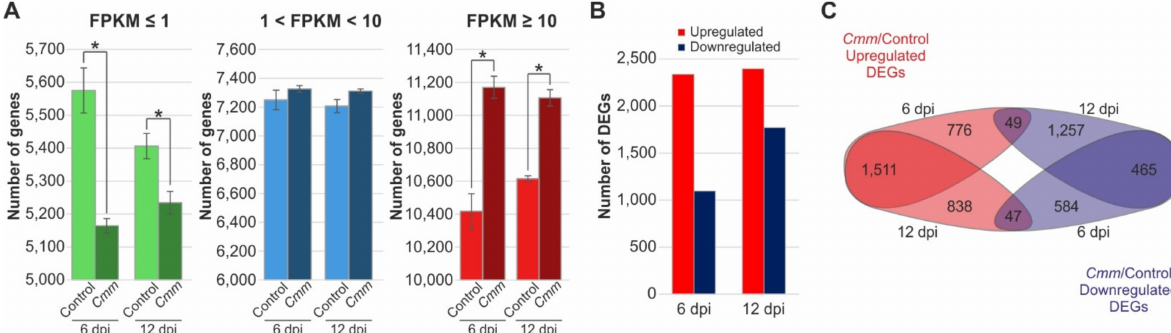
Figure 2. Overview of differentially expressed genes (DEGs) upon Cmm infection at 6 and 12 dpi. ( A ) Comparative analysis of gene expression distribution among the samples of control and Cmm infected plants. Red bars depict the highly expressed genes (FPKM ≥ 10), blue bars the genes with intermediate level of expression (1 < FPKM < 10), while green bars depict genes with low expression levels (FPKM ≤ 1). Values are mean ± standard deviation of three biological replicates of each sample. * p < 0.05 indicates significant difference between control and Cmm infected samples judged by Student’s t -test. ( B ) The number of genes that were significantly upregulated or downregulated in response to Cmm infection at 6 and 12 dpi. ( C ) Venn diagram showing a pairwise comparison of the number of upregulated and downregulated genes at 6 and 12 dpi of Cmm infection. Padj < 0.05 and log 2 FC ≥ 1 or ≤ −